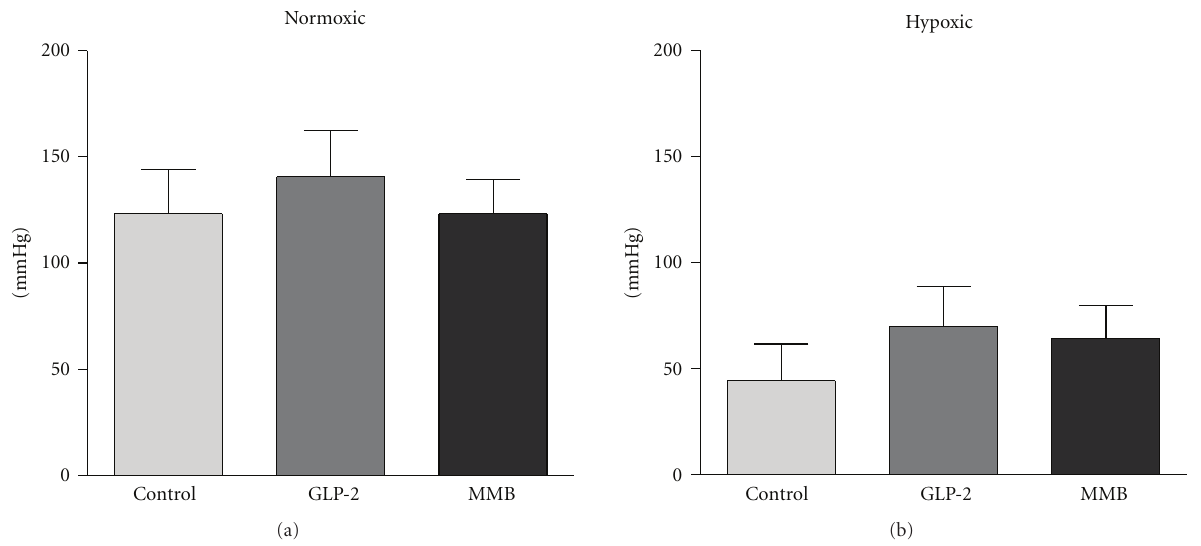
Figure 2: Anastomotic bursting pressures of normoxic and hypoxic animals. Groups treated with GLP-2, GLP-2-mimetibody (MMB) and controls. Isolated segments of intestine insu ffl ated with air under saline: pressure at which the first bubbles appear is recorded. ( n = 7 or more per group, Data: mean ± SEM, ∗ P < . 05 versus similarly treated group under normoxic conditions. Comparisons by